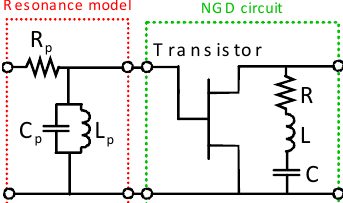
Figure 6: Resonating cell model in cascade with an NGD